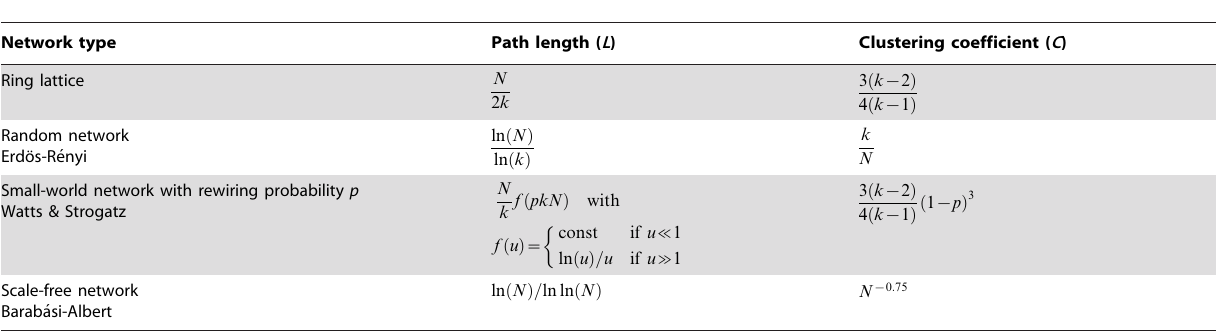
Table 1. Analytical expressions for graph measures of theoretical